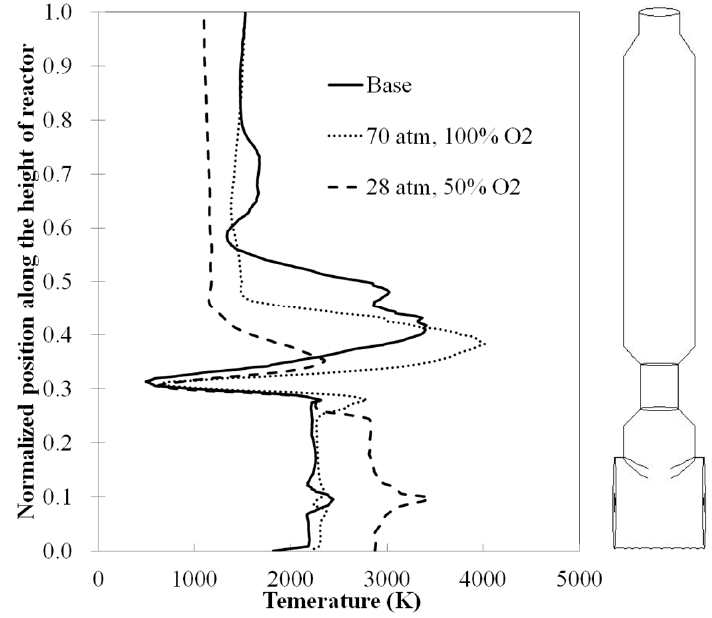
Figure 6. Comparison of temperature distributions under two pressures and two oxygen supply